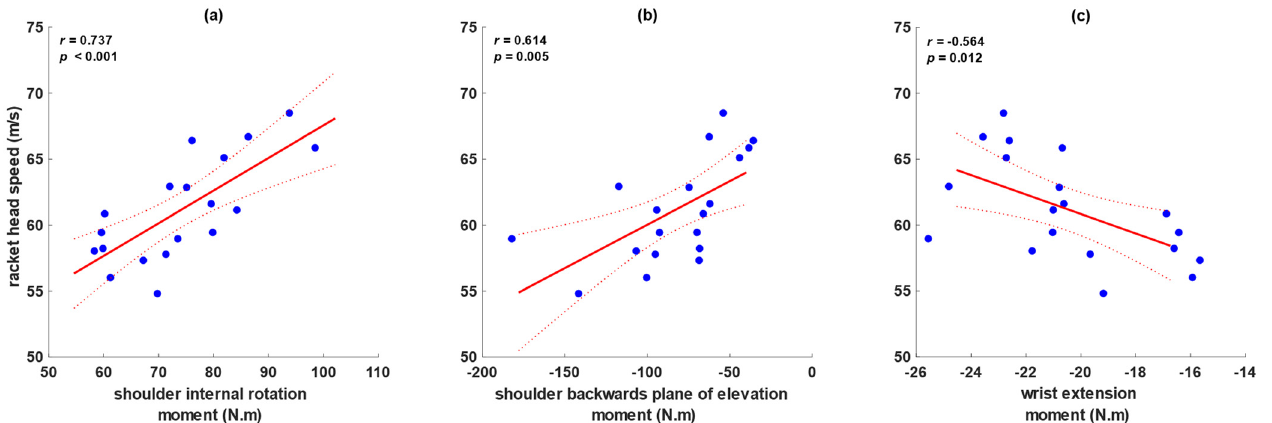
Figure 5. Correlations between racket head speed and ( a ) shoulder internal rotation; ( b ) shoulder backwards plane of elevation and ( c ) wrist extension. Regression line and 95% confidence intervals represented by solid and dashed lines, respectively.